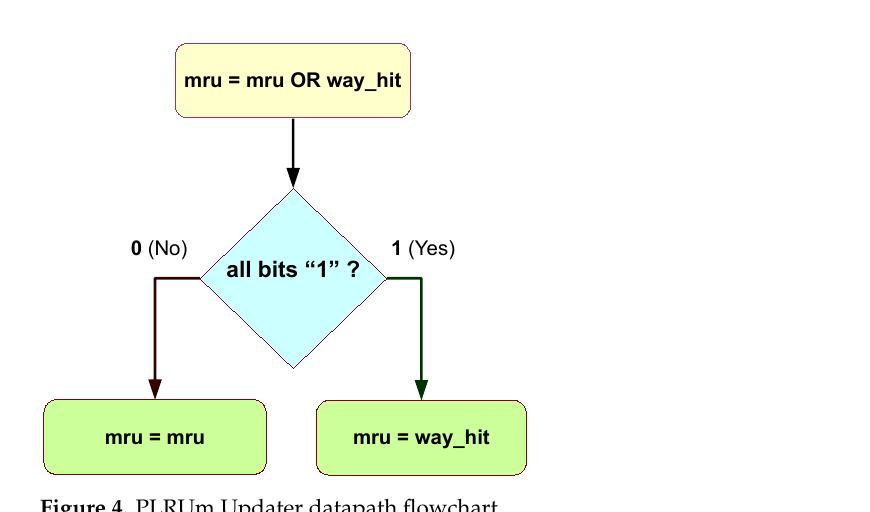
Figure 4. PLRUm Updater datapath flowchart.